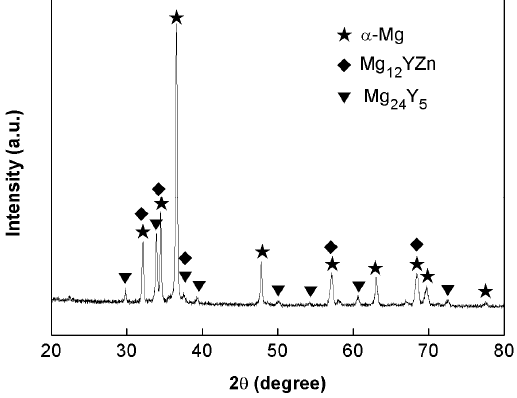
Figure 1. XRD pattern of as-cast Mg-10Y-6Gd-1.5Zn-0.5Zr alloy.